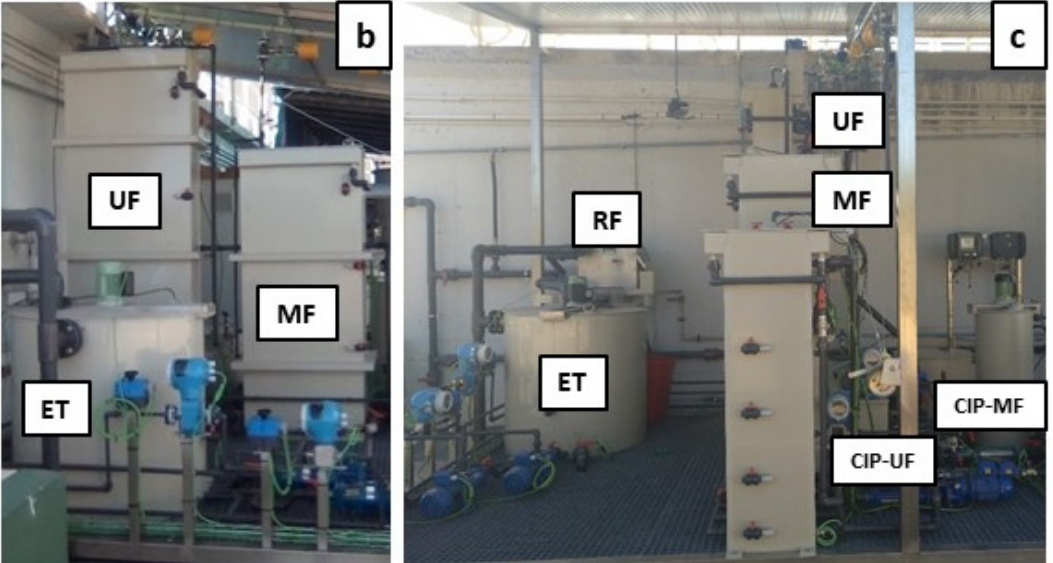
Figure 2. DMF demo-scale plant: ( a ) diagram scheme, ( b ) front view and ( c ) side view. Table 1. Influent municipal wastewater